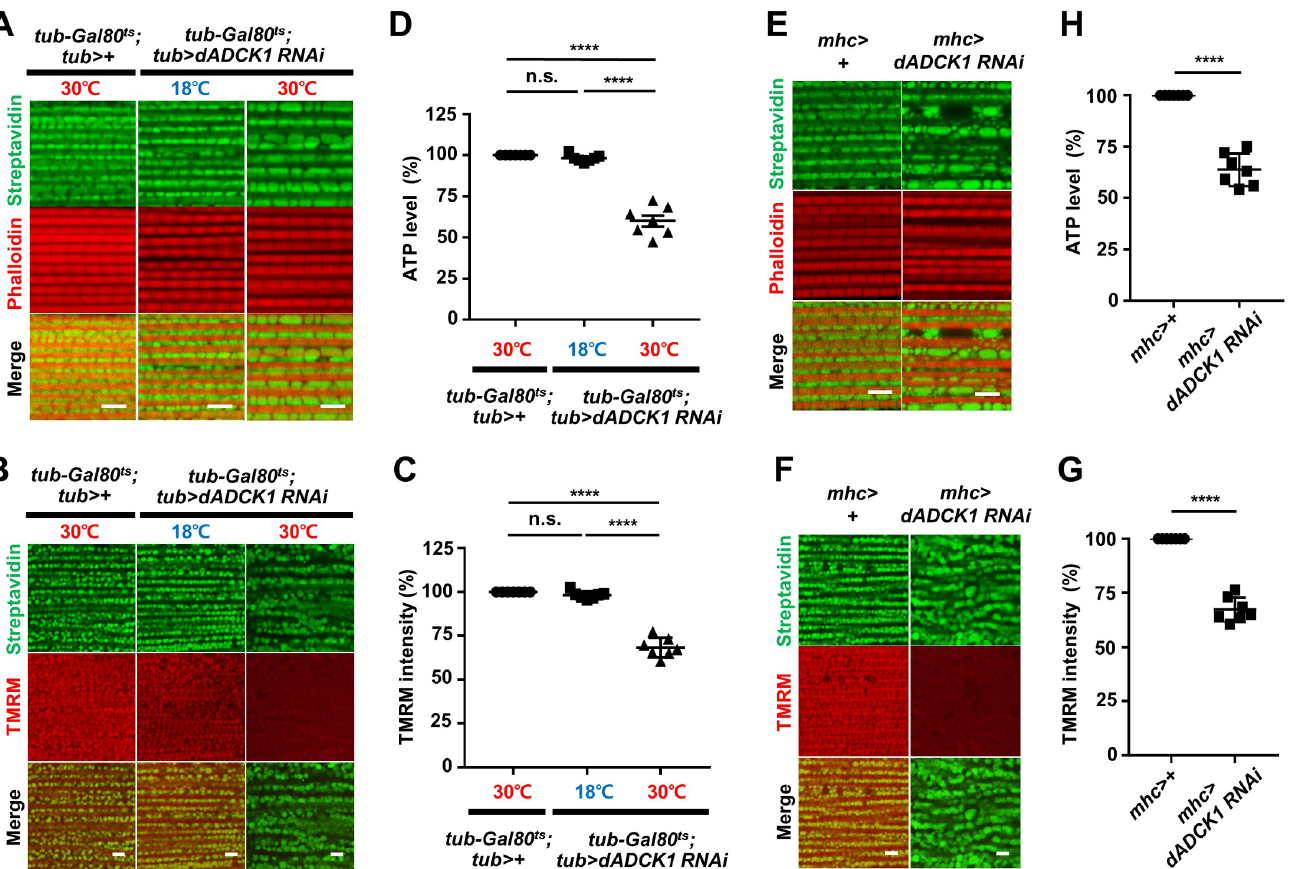
Fig 3. ADCK1 knockdown causes mitochondrial abnormality in the muscle. (A) Fluorescent confocal microscopy images of the adult fly thoraces with indicated genotypes and raised temperatures. Streptavidin (green) and phalloidin (red) staining were used to mark mitochondria and muscle actin fibers, respectively. 1,500 × magnification. Scale bars, 5 μ m. (B) Fluorescent confocal microscopy images of the adult fly thoraces with indicated genotypes and raised temperatures. Mitochondrial membrane potentials were measured by TMRM staining (red). 1,000 × magnification. Scale bars, 5 μ m. (C) Comparison of the mitochondrial membrane potentials with indicated genotypes and raised temperatures. n = 7. ���� , p < 0.0001; n.s., not significant by unpaired t-test. (D) Comparison of ATP levels in the adult fly thoraces with indicated genotypes. n = 7. ���� , p < 0.0001; n.s., not significant by unpaired t-test. (E) Fluorescent confocal microscopy images of the adult fly thoraces with indicated genotypes. 1,500 × magnification. Scale bars, 5 μ m. (F) Fluorescent confocal microscopy images of the adult thoraces with indicated genotypes. 1,000 × magnification. Scale bars, 5 μ m. (G) Comparison of the mitochondrial membrane potentials with indicated genotypes. n = 7. ���� , p < 0.0001 by unpaired t-test. (H) Comparison of ATP levels in the adult fly thoraces with indicated genotypes. n = 7. ���� , p < 0.0001 by unpaired t-test.